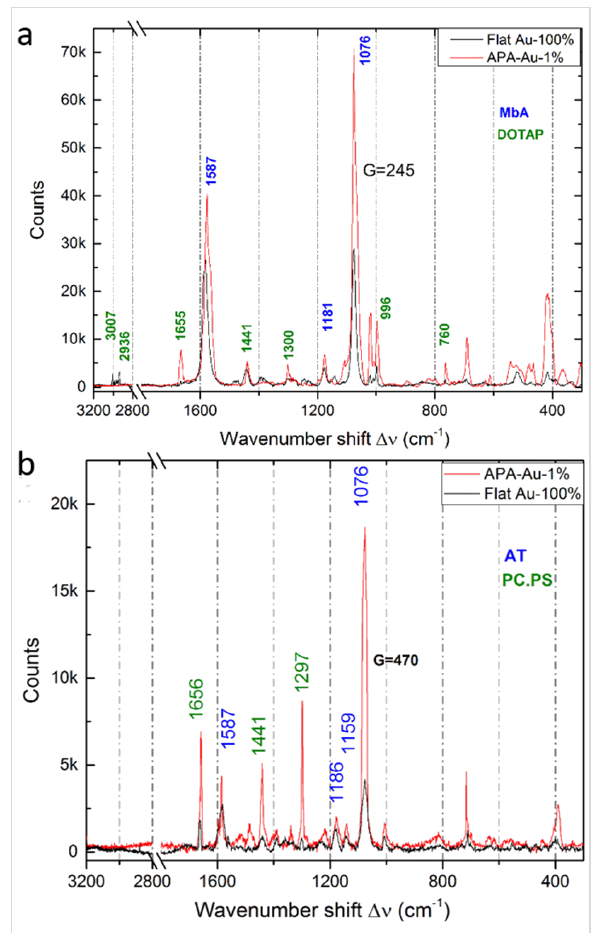
Figure 4: Raman spectra of the thiol-SLB systems on both flat Au and tAPA–Au: a) MbA and DOTAP, b) AT and POPC/POPS blend.